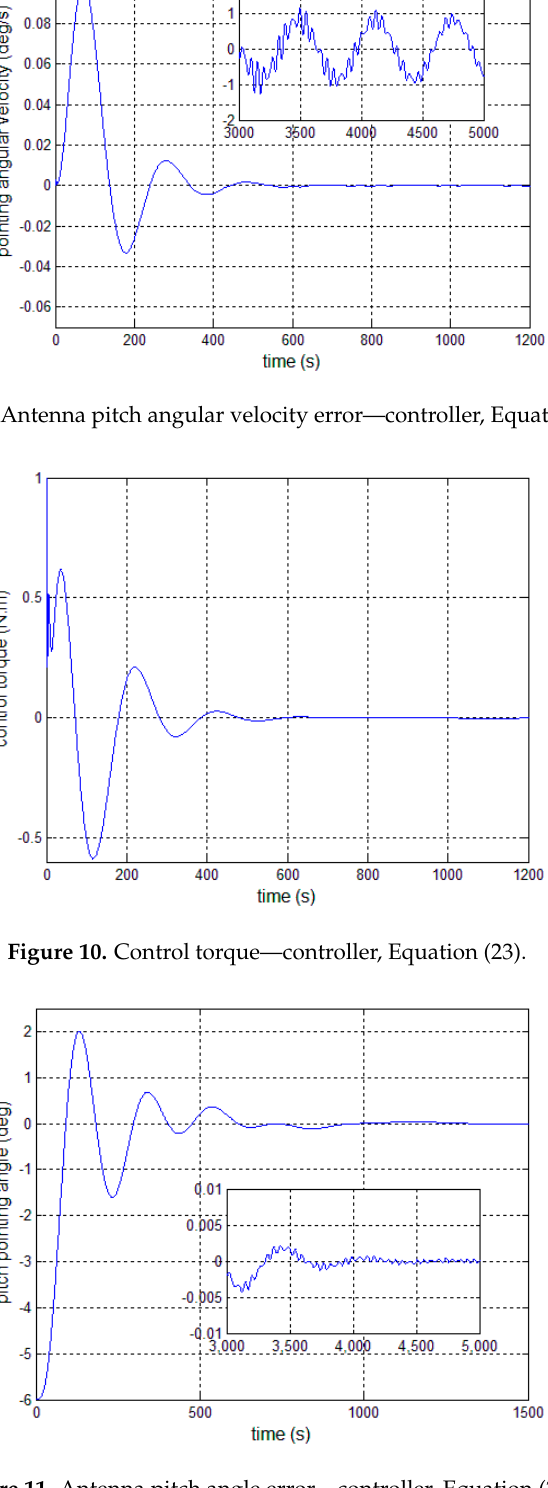
Figure 11. Antenna pitch angle error—controller, Equation (30).